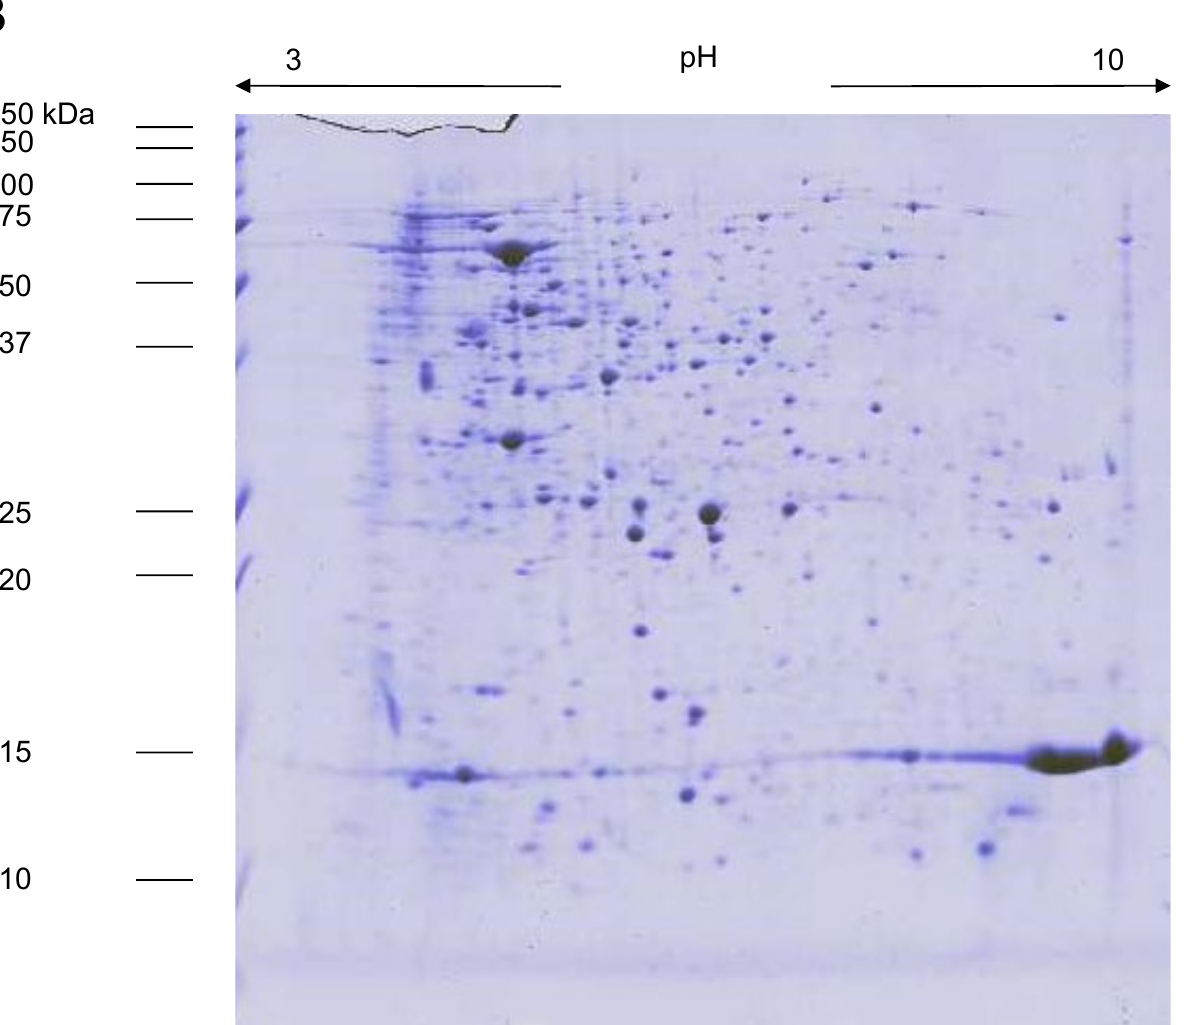
Figure 3. The 2-DE gel electrophoresis of S. maltophilia Sm126 proteins from biofilm ( A ) and planktonic ( B )